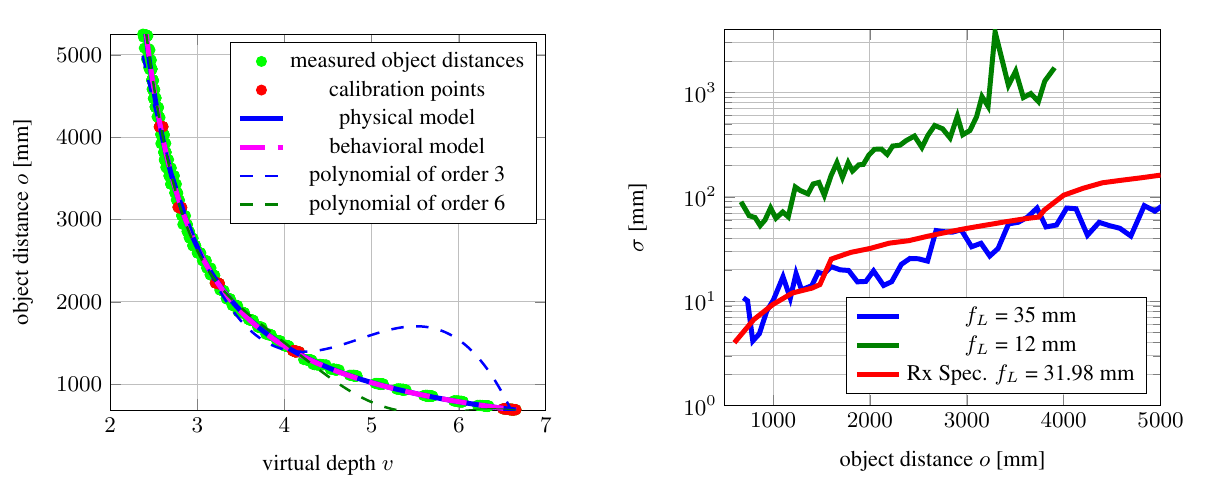
Figure 6: Depth accuracy of a Raytrix R5 camera with two dif- ferent main lens focal lengths ( f L = 35 mm and f L = 12 mm) as given in eq.